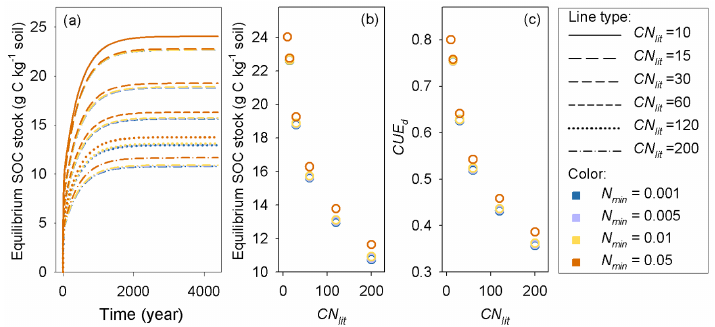
Figure 7. (a) Accumulation of soil organic carbon (SOC) for constant substrates input (plant litter) with different C:N ratios (CN lit ) at different levels of soil mineral N concentrations (N min , gNkg − 1 soil), (b) change trends of equilibrium SOC stock and (c) carbon use efficiency of decomposed litter (CUE d ) with increasing litter C:N